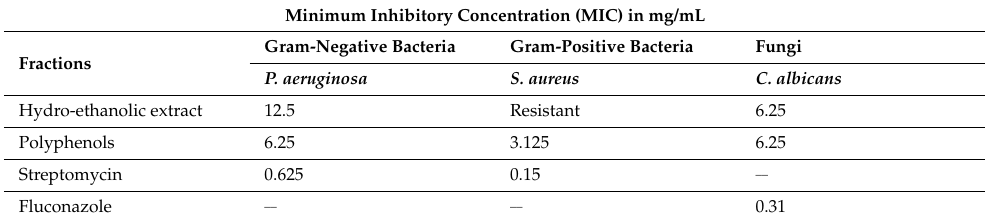
Table 5. MIC of P. sativum Hoffm. fractions tested against bacterial and fungal species.